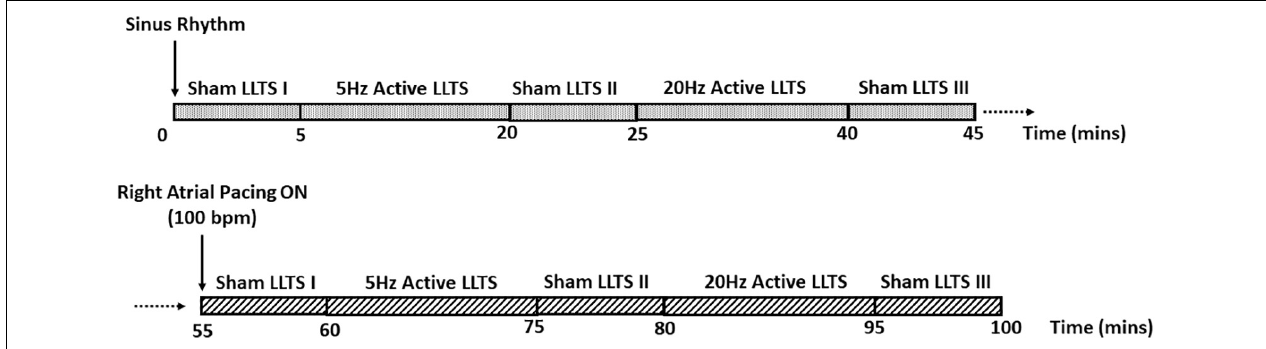
FIGURE 1 | Schematic of the study protocol. Each patient enrolled in the study first received 15 min of active LLTS at 5 Hz and 20 Hz, during sinus rhythm. 5 minutes of sham LLTS was performed before and after each active LLTS acquisition. After a 10-minute wash-out period, the 45-minute stimulation protocol was repeated with concomitant atrial pacing at 100